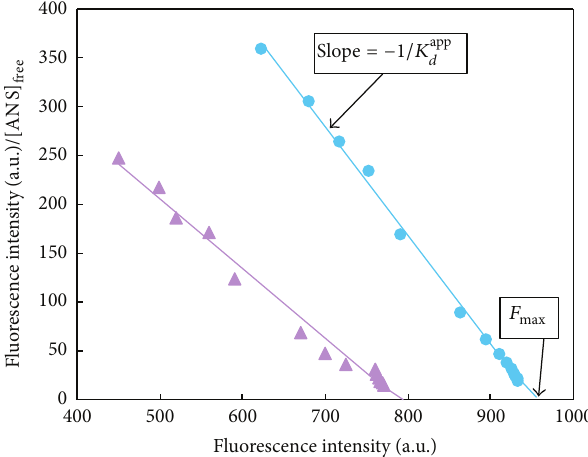
Figure 8: Scatchard plots for titration of HSA with increasing concentrations of ANS in the absence ( ∙ ) and presence ( 󳵳 ) of 3 𝜇 M of isoimperatorin. 𝐹 max and 1/𝐾 app 𝑑 values were obtained from the 𝑥 -intercept and slope of this plot. For interpretation of references to color in this figure legend, the reader is referred to the web version of this